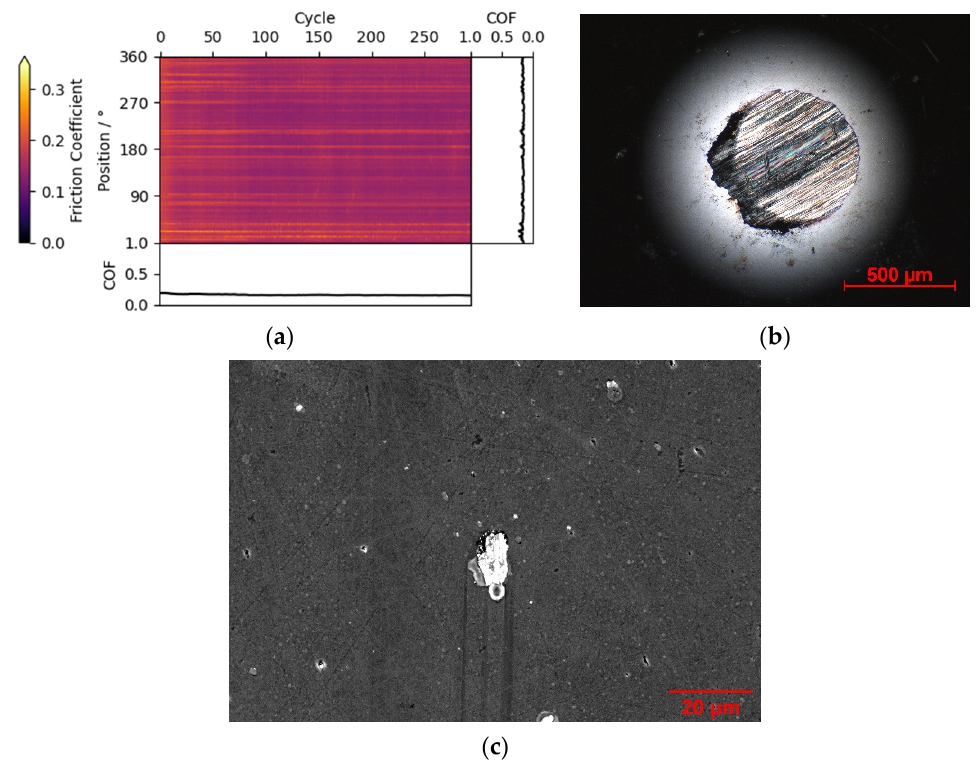
Figure 4. ( a ) Friction triboscopic image of ta-C:B:N vs. a steel ball counter body in humid air with pronounced LOCAL features. ( b ) Micrograph of worn counter body. ( c ) SEM image of wear track with visible transferred steel particle .